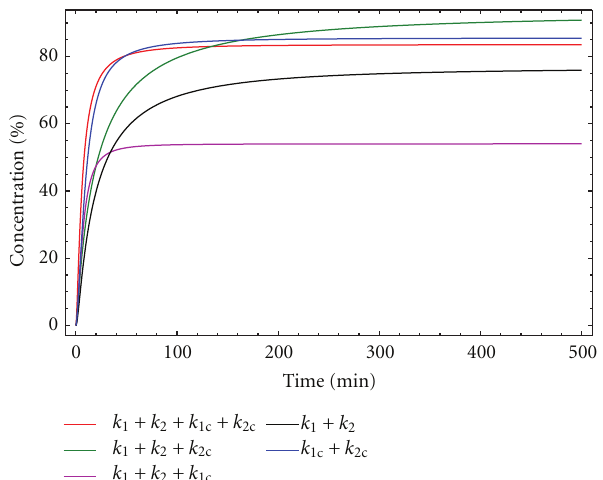
Figure 15: Concentration macrocycle D versus time for kinetic model 8. [A] 0 = [B] 0 = 0.005 M, [Br − ] 0 = 0.0025 M, k 1 = 10M − 1 min − 1 , k 1 c = 4000 M − 2 min − 1 , k 2 = 0.5 min − 1 and k 2 c = 400M − 1 min − 1